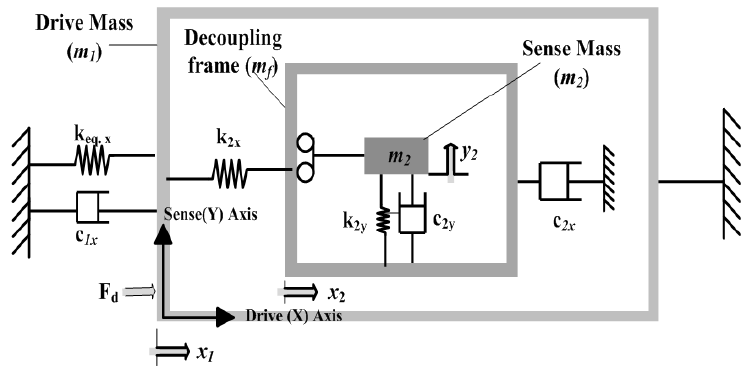
Figure 5: Lumped mass-spring model of the 3-DoF